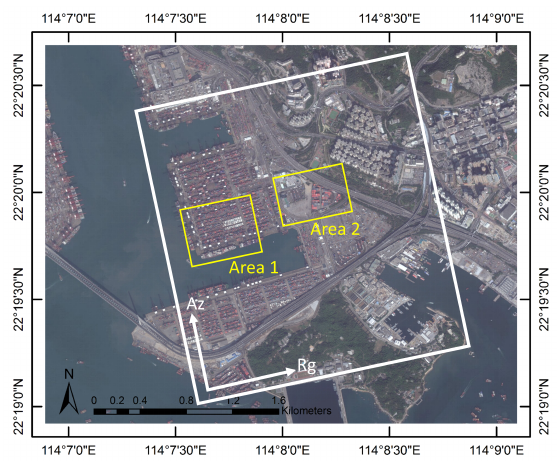
Figure 6. The area of interest (white box) in Hong Kong retrieved from World Imagery (Esri, Redlands, CA, USA). Two areas were selected for detailed comparisons.